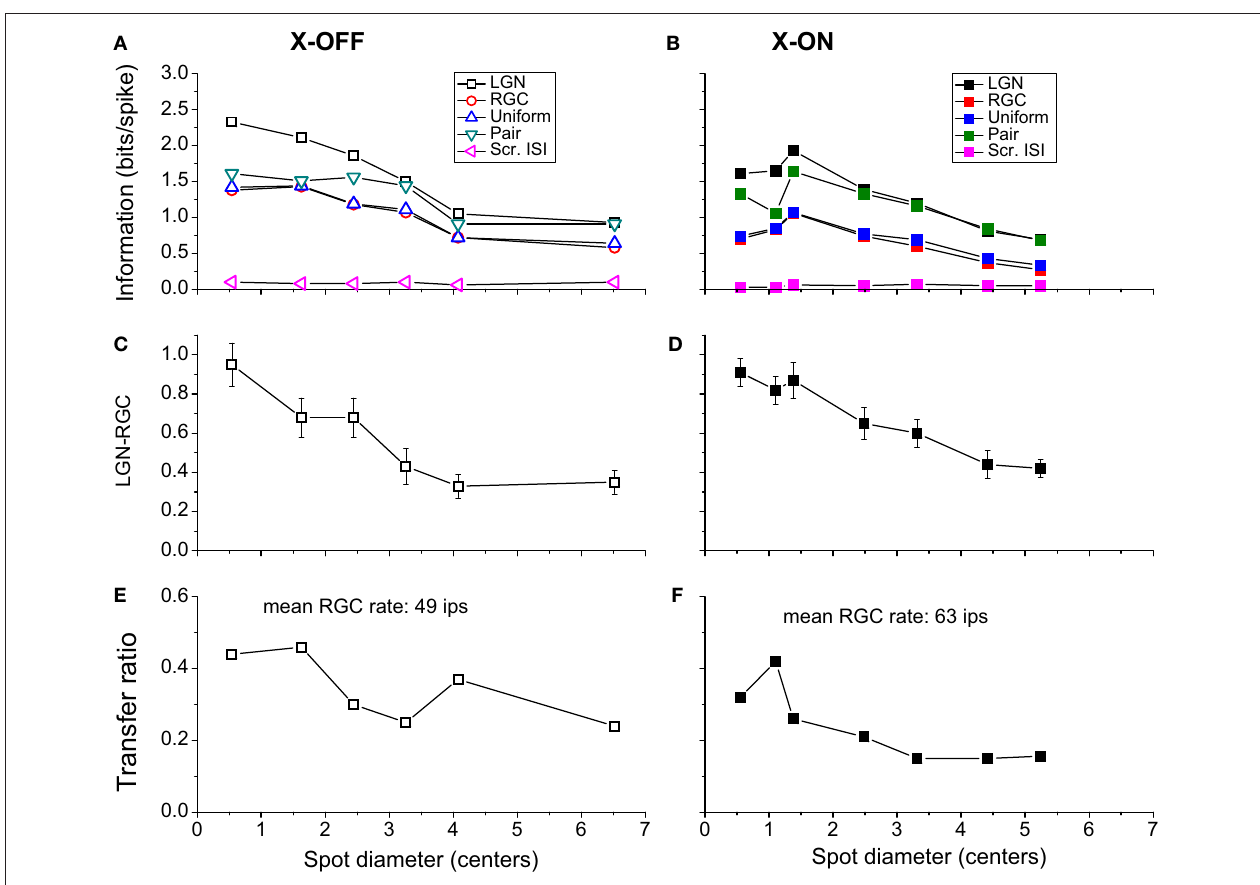
FIGURE 2 | The relation between information transmission and stimulus size. (A,B) Single spike information (in bits/spike) as a function of spot size for two representative cells (# 7 and 8, Table 1 ). The LGN spike train (black) carries more information per spike than the corresponding RGC spike train (red). For comparison, we have included the results of three different deletion procedures, which left the number of LGN spikes the same as it was in the real one: random deletion of events from the RGC spike train (green), considering only pairs of